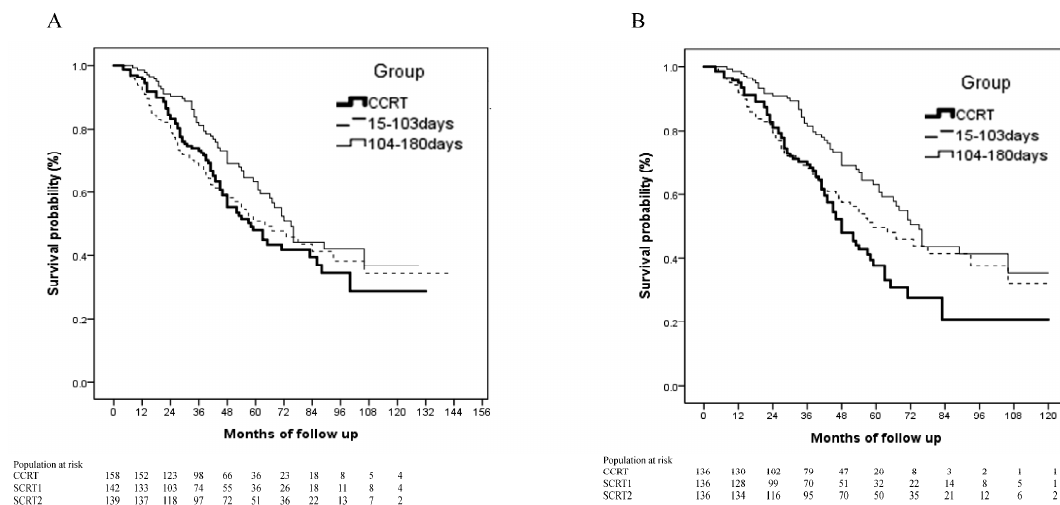
Figure 2. Kaplan–Meier survival curves of OS in patients treated according to three PORT schedules (CCRT, SCRT1 [15–103 days], SCRT2 [104–180 days]). ( A ) Before PSM, log-rank test, p = 0.095; CCRT vs. SCRT1, p = 0.94; CCRT vs. SCRT2, p = 0.037; and ( B ) After PSM, log-rank test, p = 0.003; CCRT vs. SCRT1, p = 0.188; CCRT vs. SCRT2, p < 0.01). Abbreviations: CCRT: concurrent chemoradiation; OS: overall survival; PORT: postoperative radiotherapy; PSM: propensity score matching; SCRT1: sequential chemoradiation group 1; SCRT2: sequential chemoradiation group 2.